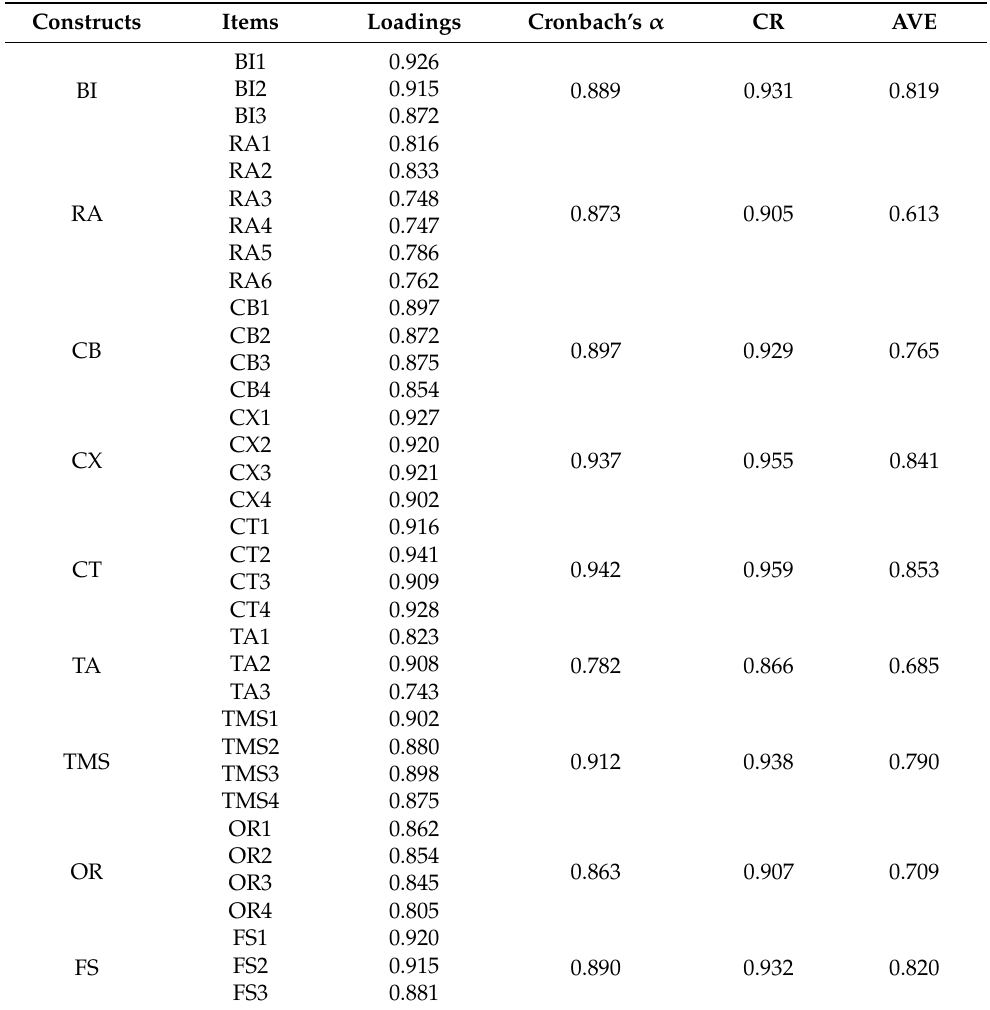
Table 2. Convergent validity and reliability